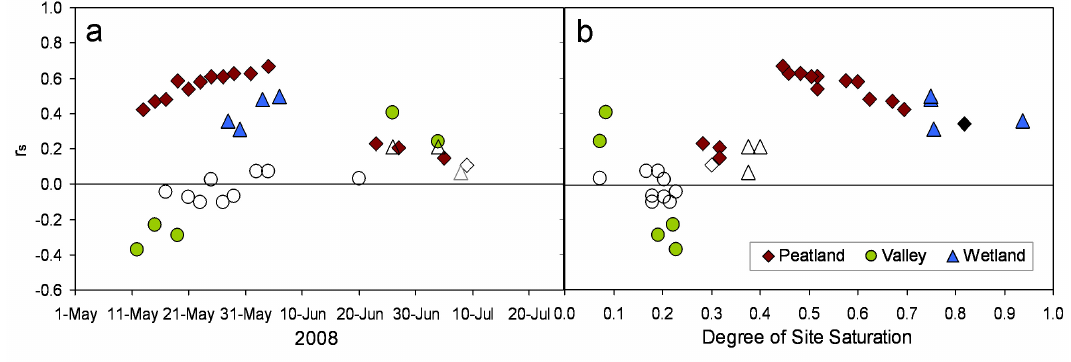
Fig. 10. The Spearman rank correlation coefficient ( r s ) between shallow soil moisture and frost table depth: (a) for all survey dates at the three study sites, and (b) r s over the sites’ median degree of saturation, S (volumetric water content divided by porosity). The line of best fit through data from all three sites is r s = 0 . 8S–0.08 with r 2 = 0 . 42. When a location thawed deeper than 1m, the grid was removed from the remaining analysis. Closed and open symbols show significant and non-significant r s at α = 0 . 05,